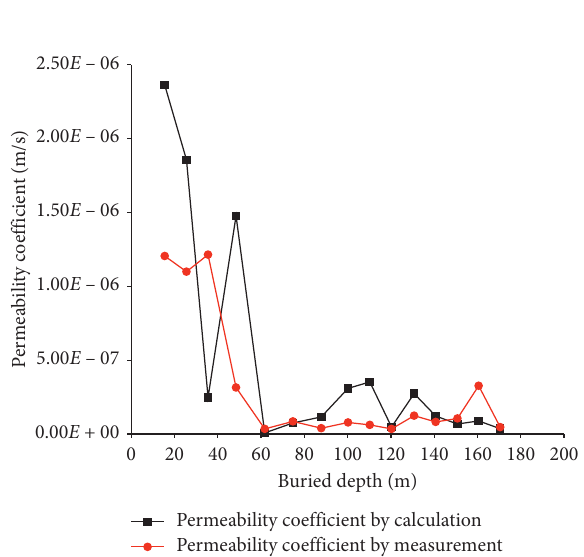
Figure 7: Comparison of the permeability coefficient by mea- surement and